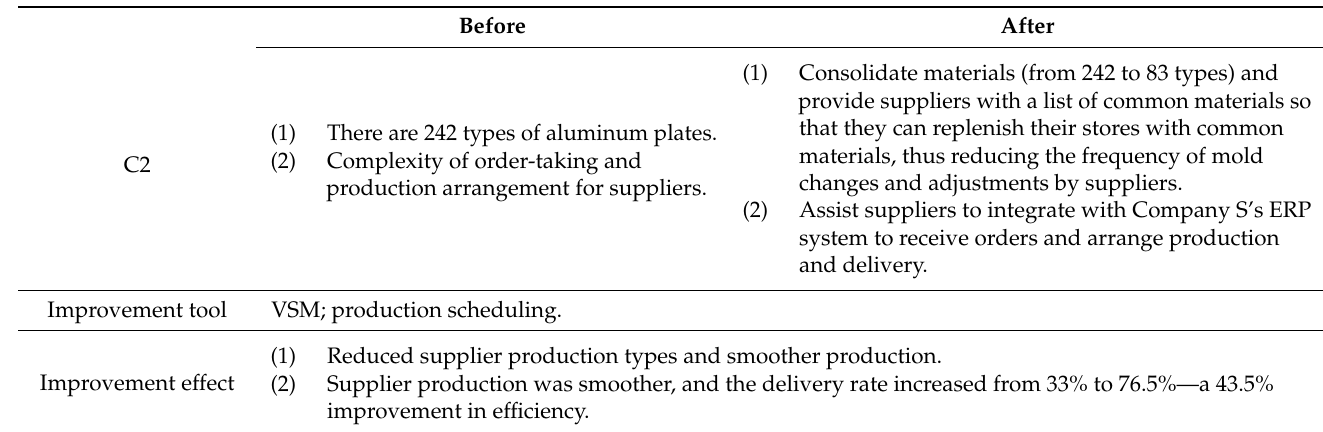
Table 6. C2 improvement project and its improvement effects (before and